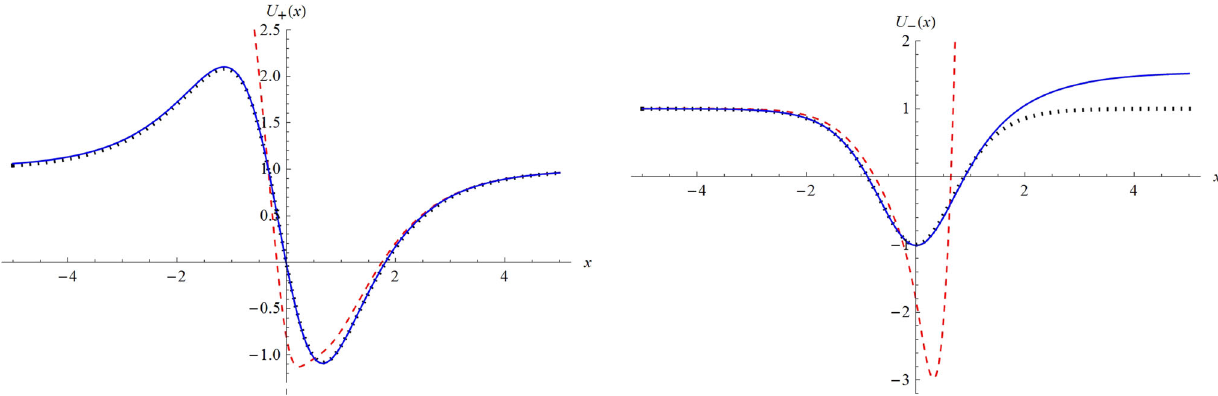
Fig. 8 Quantum-mechanical potentials U + (on the left) and U − (on the right) for b 3 = 0 and α = 1. For both, we have plotted the values a 2 = 0, a 2 = − 0 . 01, and a 2 = − 0 . 8, depicted with dotted, solid, and dashed lines, respectively